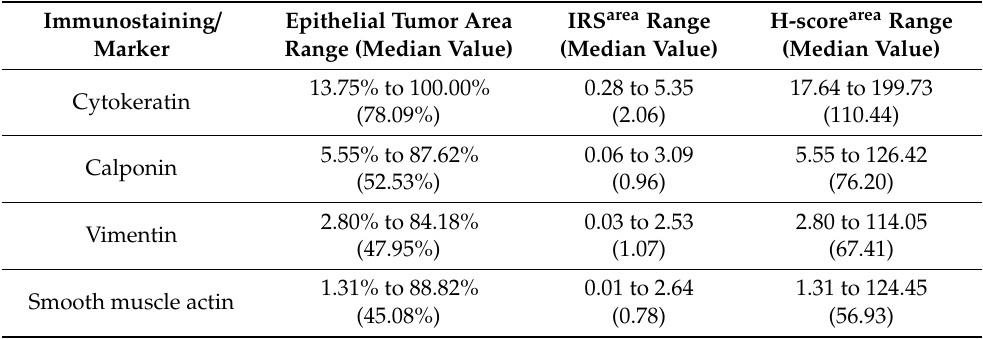
Table 3. Measurement of Tumor Areas Positive for Cytokeratin, Smooth Muscle Actin, Vimentin, and Calponin, as well as IRS and H-Scores in 110 Pet Rabbit Mammary